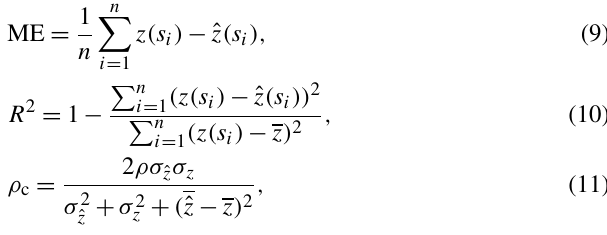
spatial distribution of SOC fractions with quantile regression models